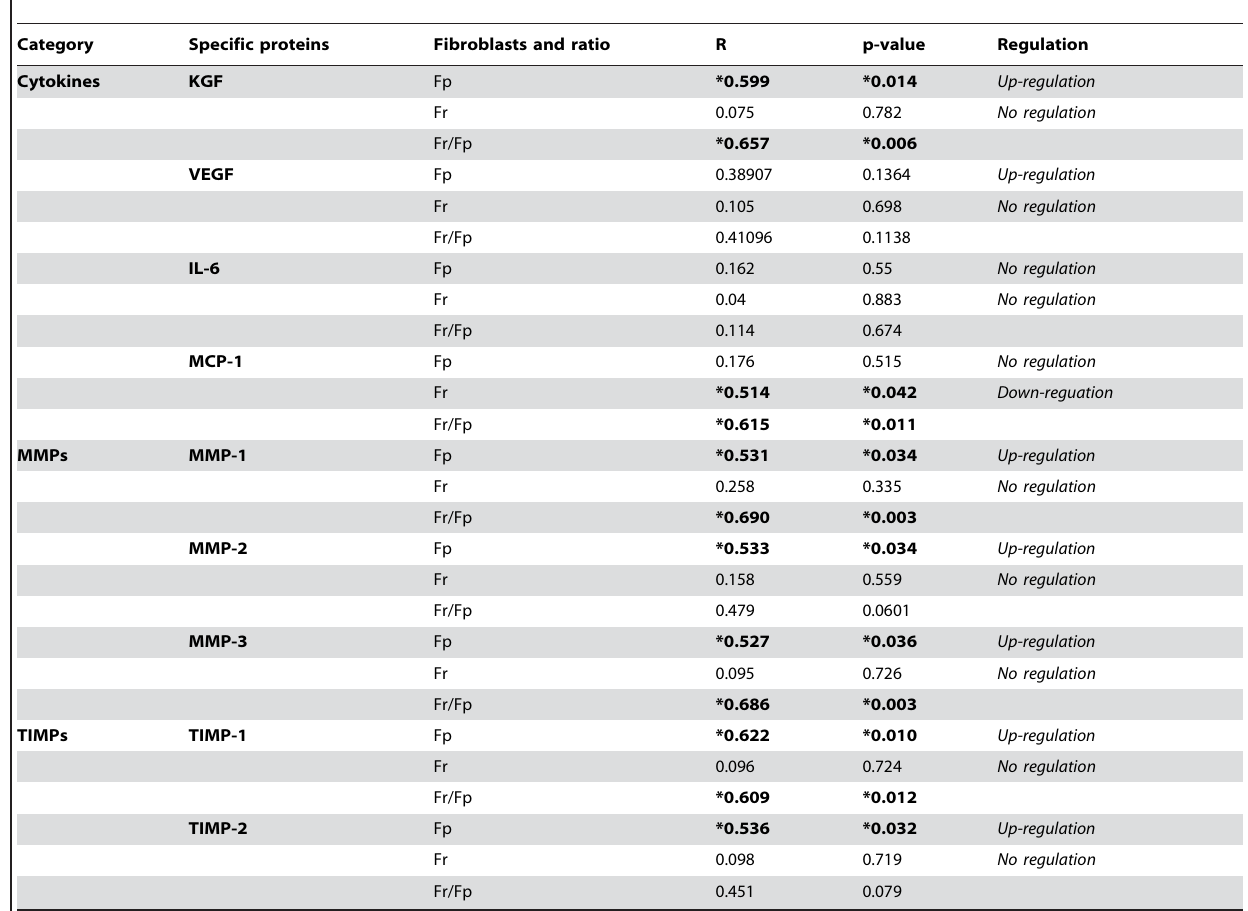
Table 1. Secretion profiles of cytokines, MMPs and TIMPs by Fp and Fr as a function of donor’s